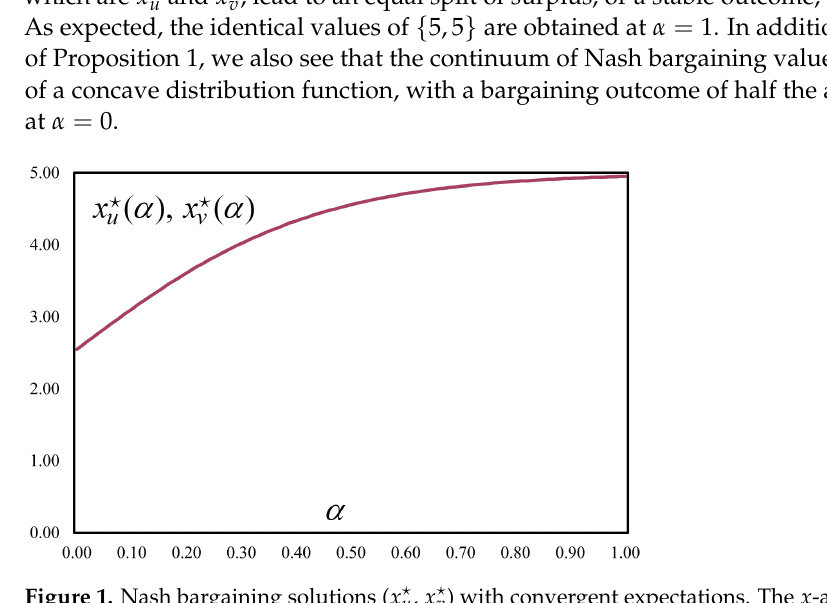
Figure 1. Nash bargaining solutions ( x (cid:63) u , x (cid:63) v ) with convergent expectations. The x -axis corresponds to the decay parameter ( α ). The y -axis denotes Nash allocations ( x α u , x α u ).